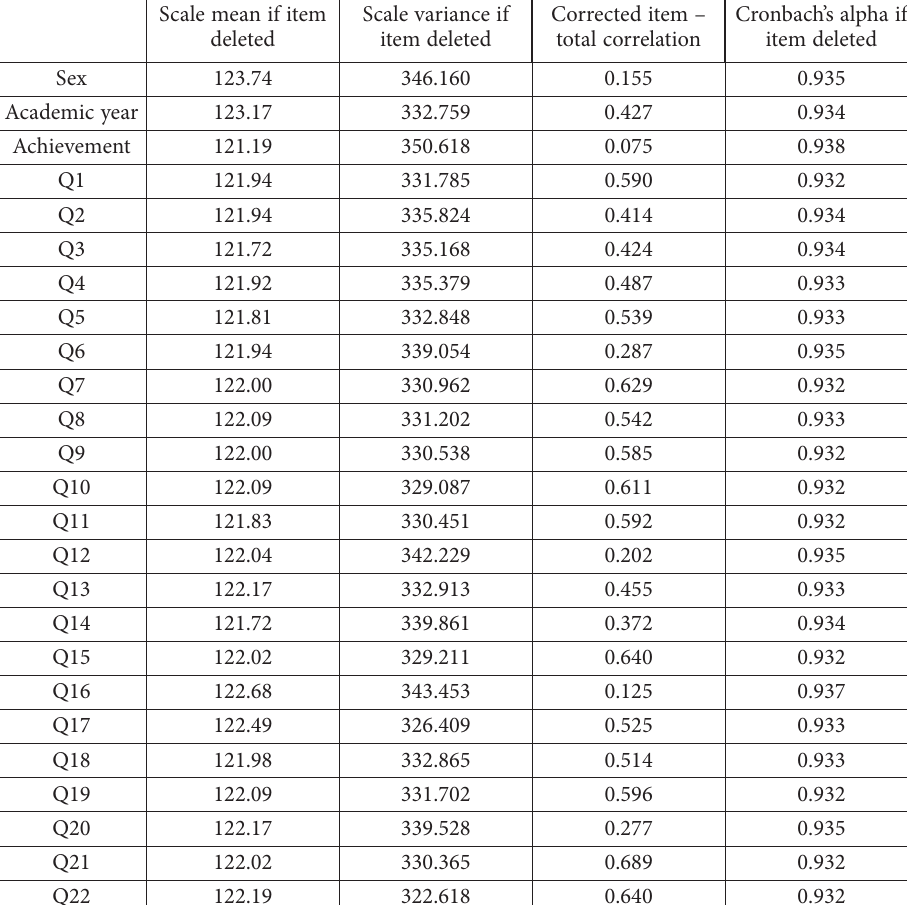
Table 2. Retest method data (re-test) for the creative thinking scale (source: created by